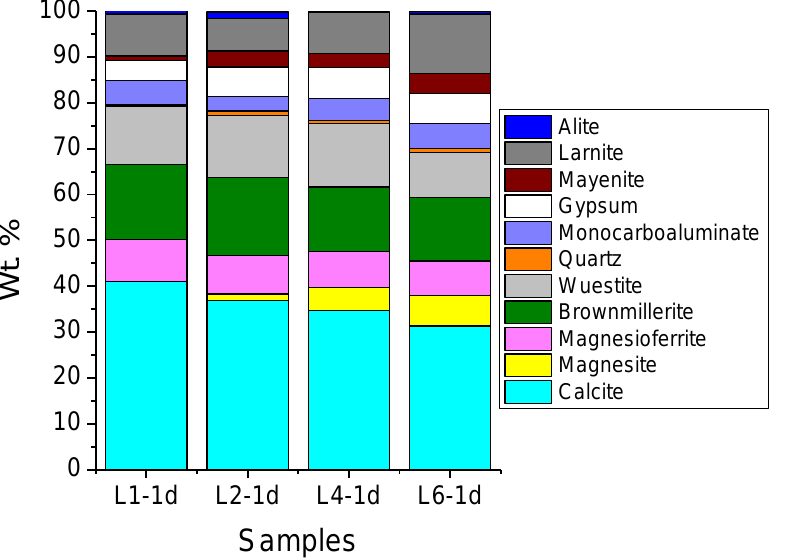
Figure 13. Semi-quantitive XRD analyses of samples with different w/s values at 1 d. (L1: 1/5, L2: 1/6, L4: 1/8, L6: 1/10).